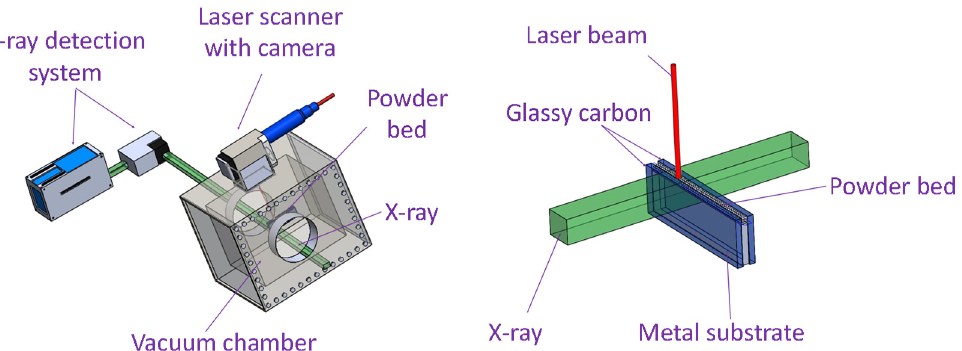
Figure 2. Schematic of the in-situ high-speed synchrotron X-ray imaging system and the sample assembly. The X-ray passes through the sample and is detected by the X-ray detection system. A visible light camera is used to ensure proper laser-sample alignment. Two glassy carbon walls are used to hold the metal substrate and the powder bed while ensuring X-ray transparency along the X-ray beam path. More details regarding in-situ high-speed synchrotron X-ray imaging are in ref- erence